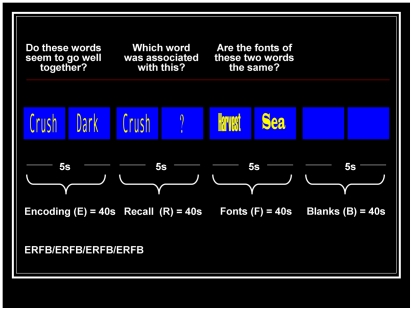
Graphic representation of the verbal paired associates learning paradigm.